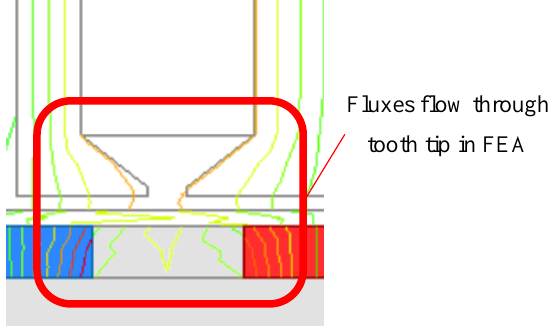
Figure 26. Tooth Tip Effect on Airgap Flux Density in FEA.